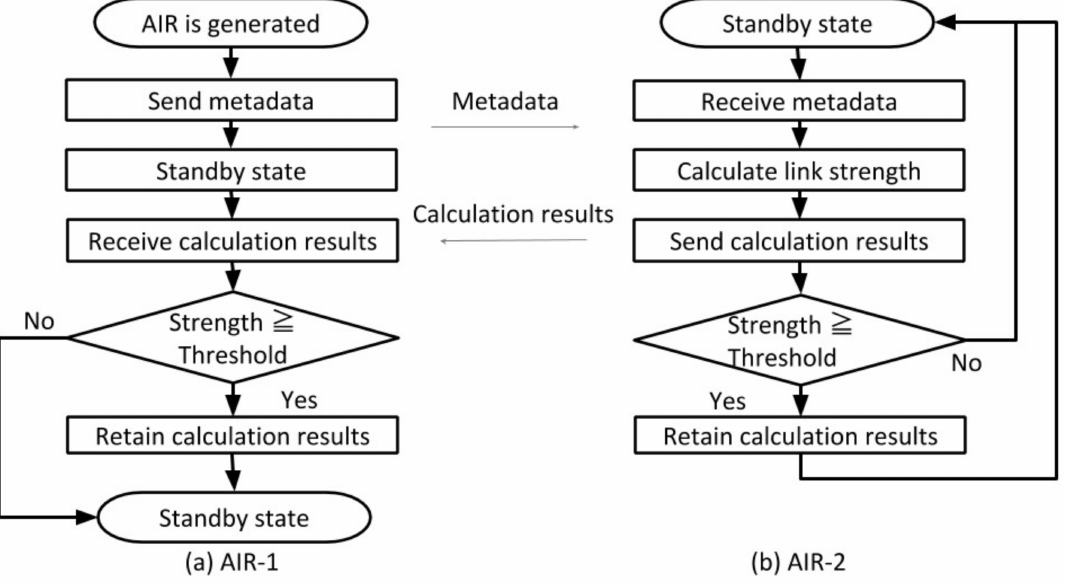
Figure 5. Flowchart of memory structure construction between AIRs. Table 4. Example of deriving similarity and proximity between memory fragments A and